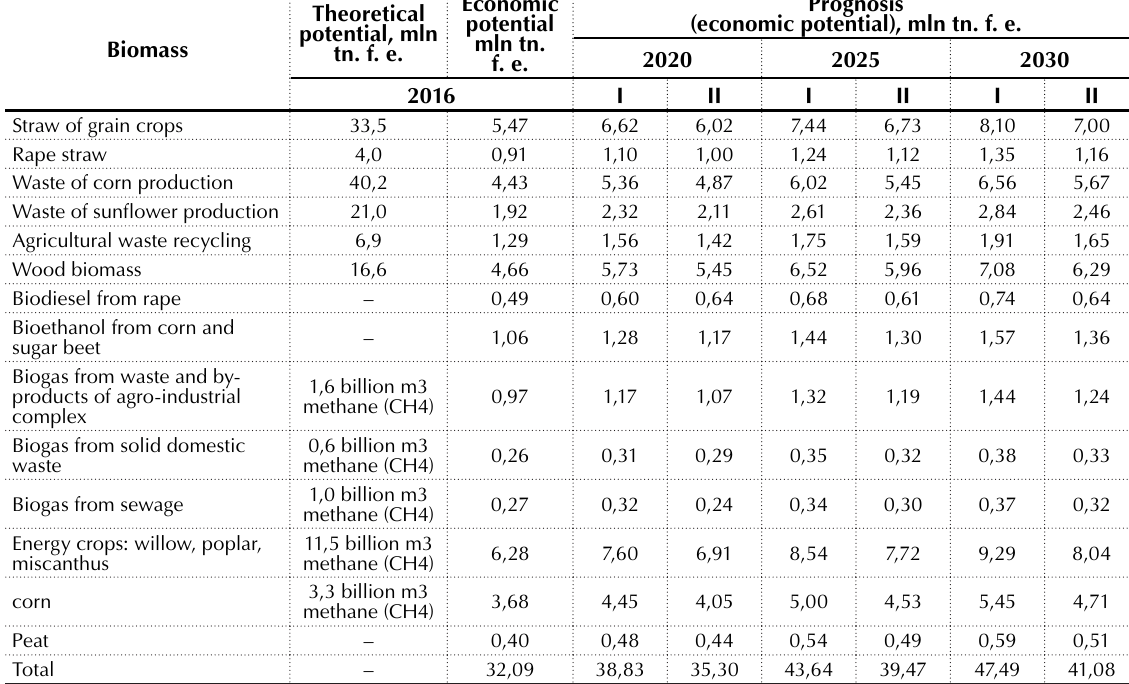
Table 1. Energy potential of biomass prognosis in Ukraine for 2020–2030